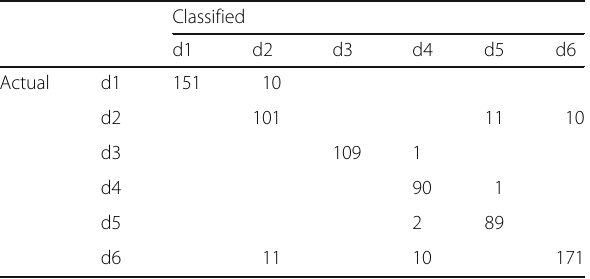
Table 3 Confusion matrix for the thermal image